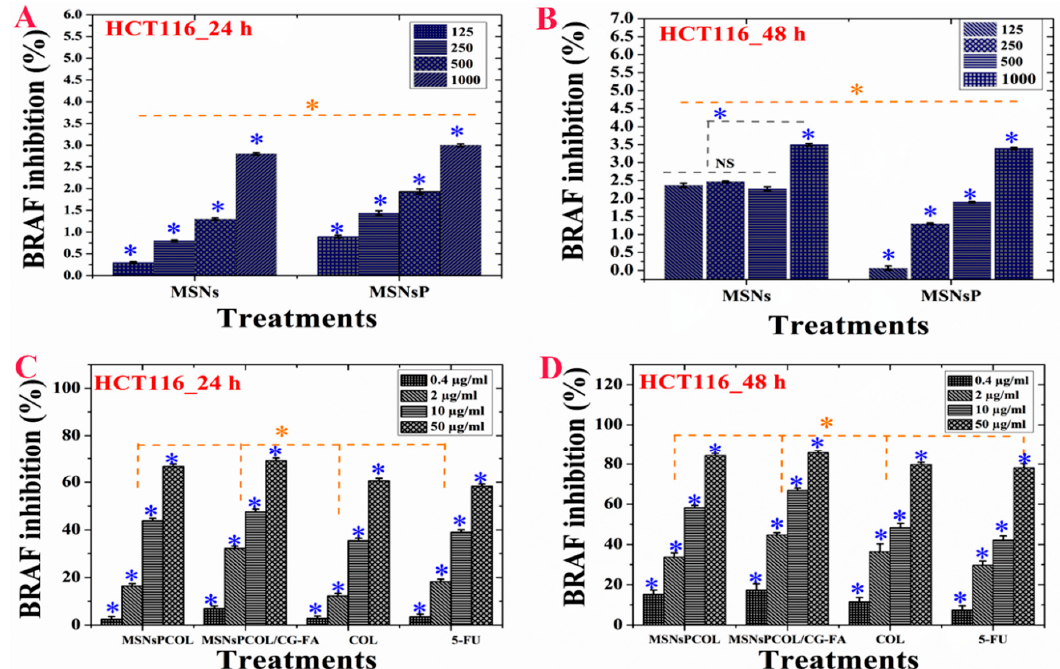
Figure 9. ( A ) BRAF activity of HCT116 cells treated with MSNs and MSNsP as a function of concentration. ( B ) BRAF activity of HCT116 cells treated with the proposed delivery system and compared to the model anticancer drug (5-FU) as a function of concentration. ( C ) BRAF inhibition activity of HCT116 cells treated with MSNs and MSNsP as a function of concentration. ( D ) BRAF inhibition activity of HCT116 cells treated with the proposed delivery system and compared to the model anticancer drug (5-FU) as a function of concentration. Note: A blue asterisk (*) indicates significant ( p < 0.05) di ff erences between tested concentrations, whereas an orange asterisk (*) indicates significant di ff erences between tested samples. All data are expressed as mean ±